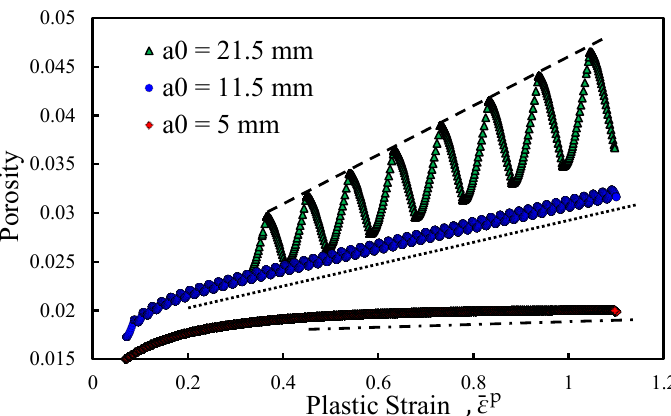
Figure 11. Porosity evolution with plastic strain growth for different initial crack lengths ( a 0 ) in natural scales. Crack closure is enabled.